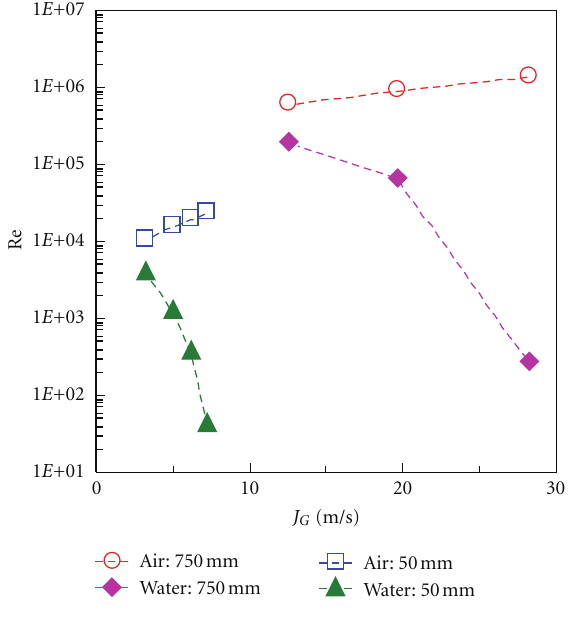
Figure 10: Reynolds